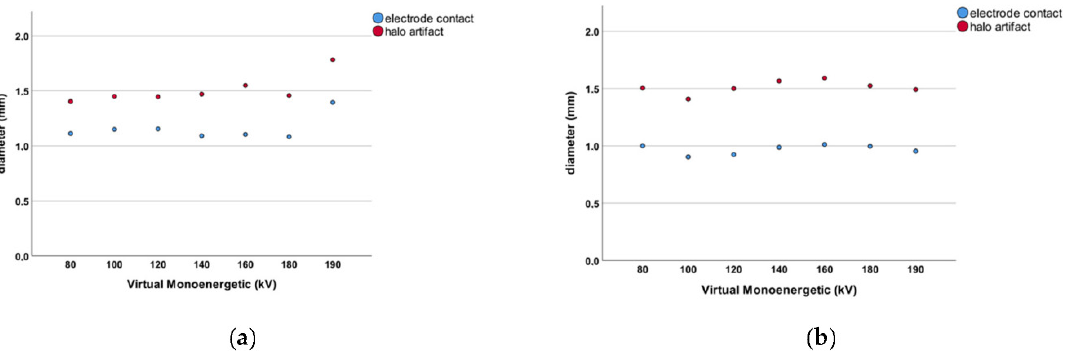
Figure 3. ( a ) Dot chart for the PCD-CT measurements. The blue dots represent the diameter of the individual electrode contacts for each VME setting. The red dots represent the diameter of the respective halo artifact for that VME increment. ( b ) Dot chart for the EID-CT measurements. The blue dots represent the diameter of the individual electrode contacts for each VME setting. The red dots represent the diameter of the respective halo artifact for that VME increment.